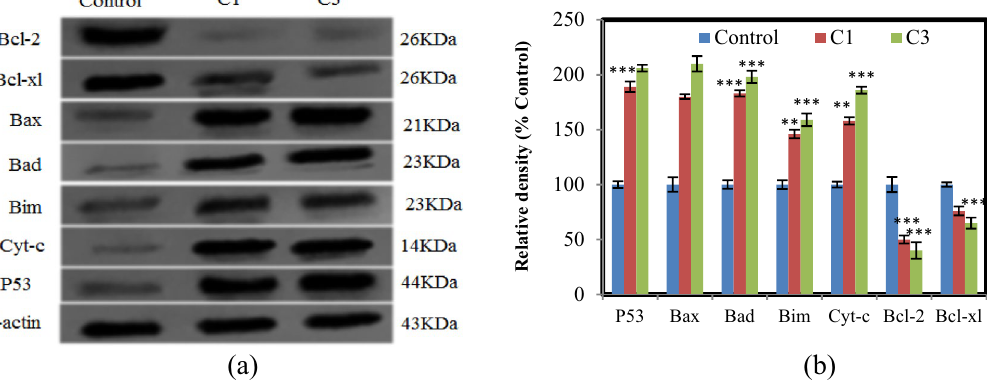
Figure 9. Effect of complexes on the apoptosis protein levels in A375 cells for 24 h. ( a ) Western blot analysis of p53, Bcl − 2, Bcl − xl, Bax, Bad, Bim, and Cyt-c levels after complex treatment. β − actin was used as an internal control. The blots were cropped before hybridization with antibodies during blotting. ( b ) Densitometric analysis of the expression of p53, Bcl − 2, Bcl − xl, Bax, Bad, Bim, and Cyt-c. The percentage values are those relative to the control. Results are the mean ± S.E.M (n = 3) * p < 0.05, ** p < 0.01, *** p < 0.001.